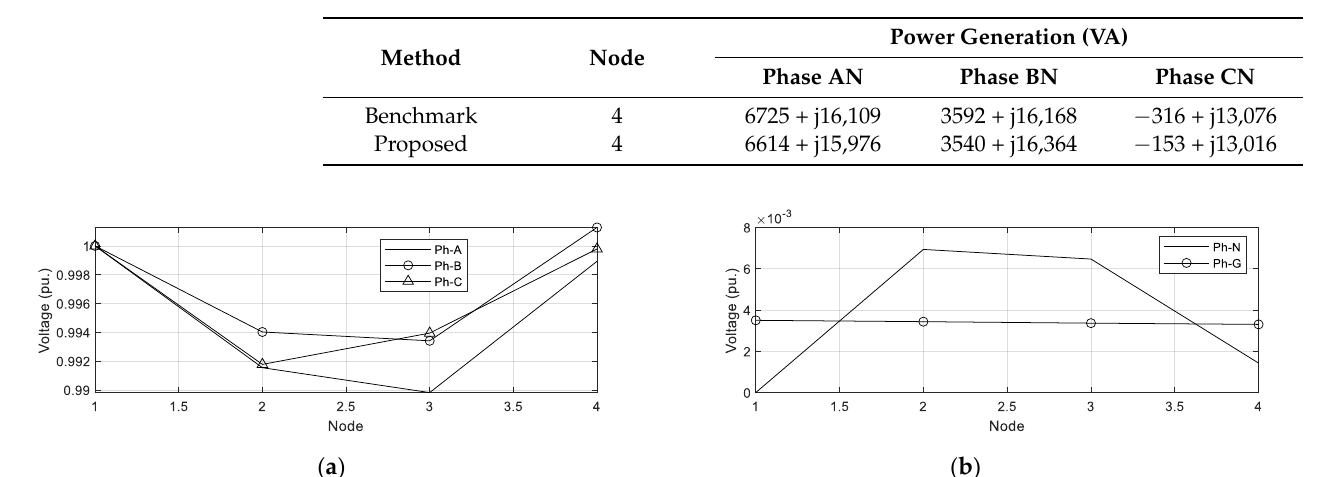
Figure 12. Phase voltage results of ( a ) Phase − A, − B, and − C and ( b ) Phase − N and − G.